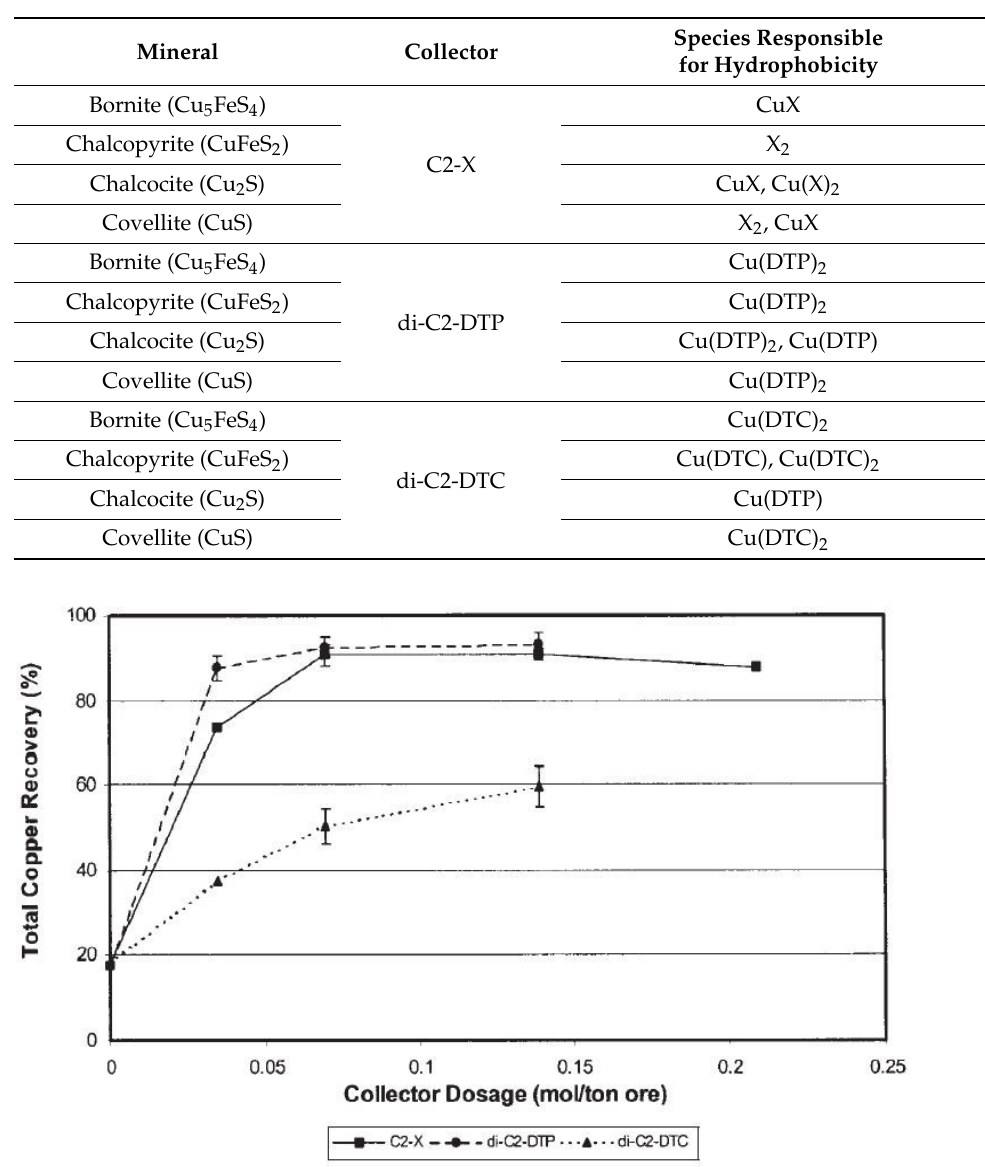
Figure 11. The total copper recovery versus collector dosage obtained with C2-X, di-C2-DTP and di-C2-DTC in the flotation of the Okiep copper ore [63] .